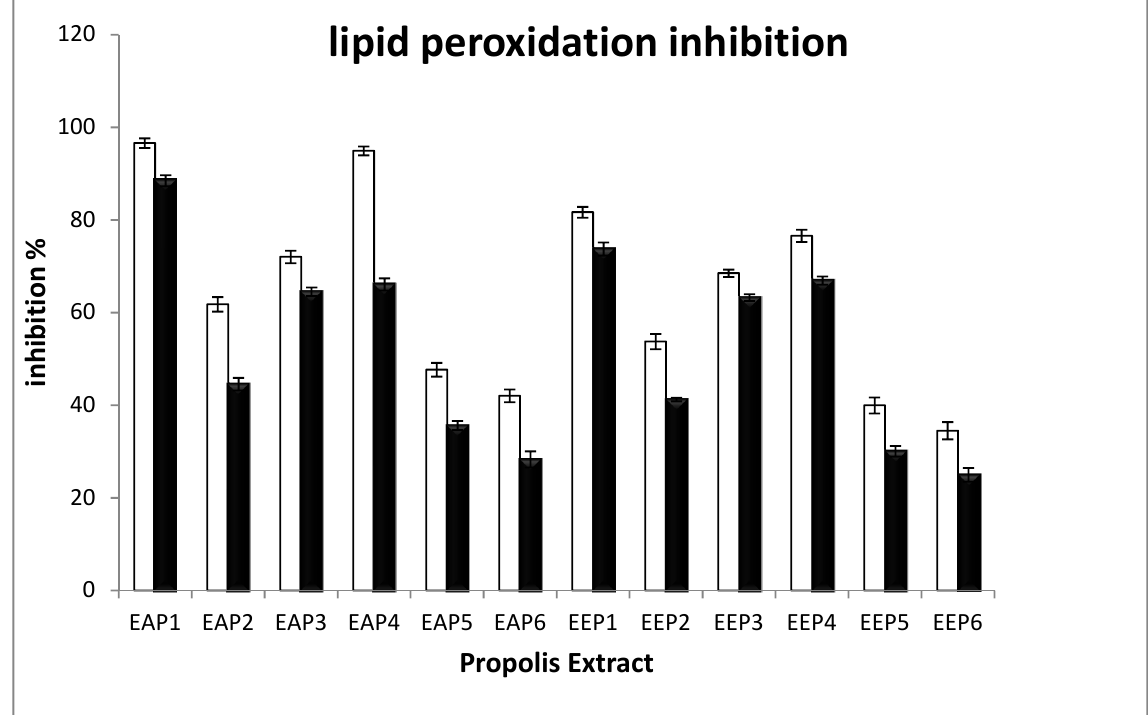
Figure 3. Percentage of lipid peroxidation inhibition. White bars indicate activities when the propolis extracts are combined within the liposomes (ST2), and the black bars illustrate lipid peroxidation inhibition when the propolis extract are added before H The percentages of inhibition were calculated taking the control C1 and C2 as respectively 0% and 100% of